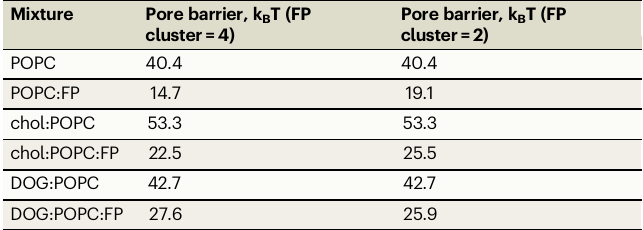
Table 1 | Barriers to pore formation depend on lipid compo- sition and FP cluster size Mixture Pore barrier, k B T (FP